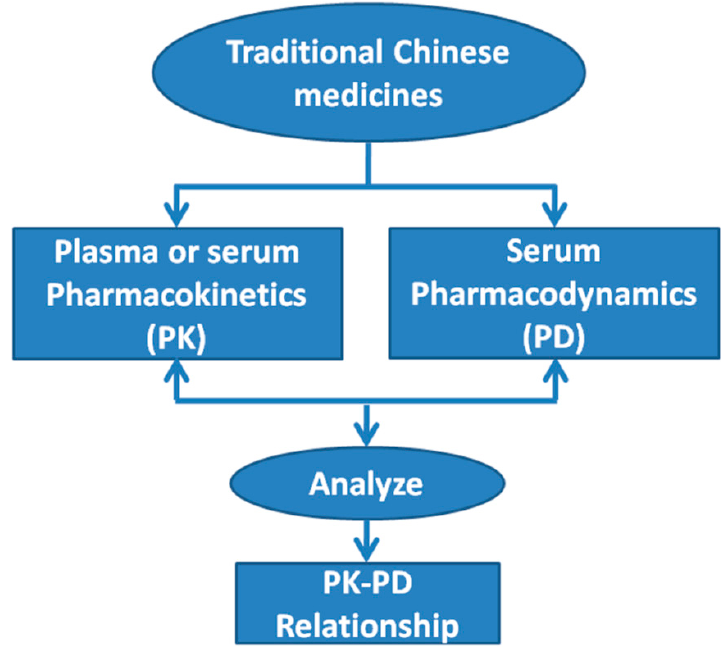
Figure 3. The pharmacokinetics (PK)-pharmacodynamics (PD) relationships for TCMs.